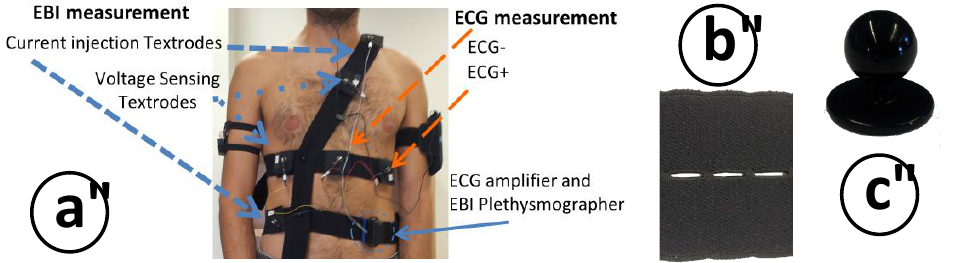
Figure 8. ( a ) Chest straps system confectioned for placement of ECG and TEB electrodes. ( b ) Detail of the elastic perforated band. ( c ) Fixation between straps through chef jacket button.